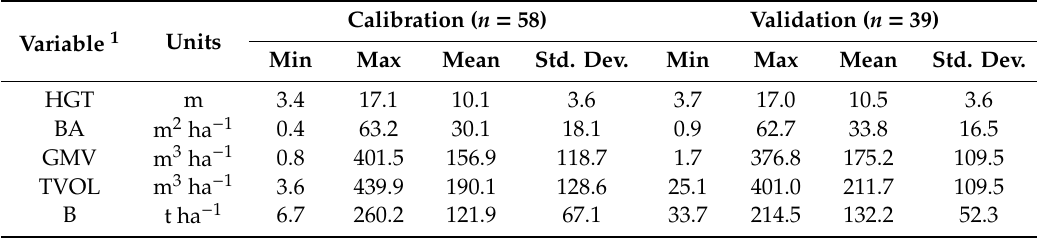
Table 1. Descriptive statistics of forest attributes for ground